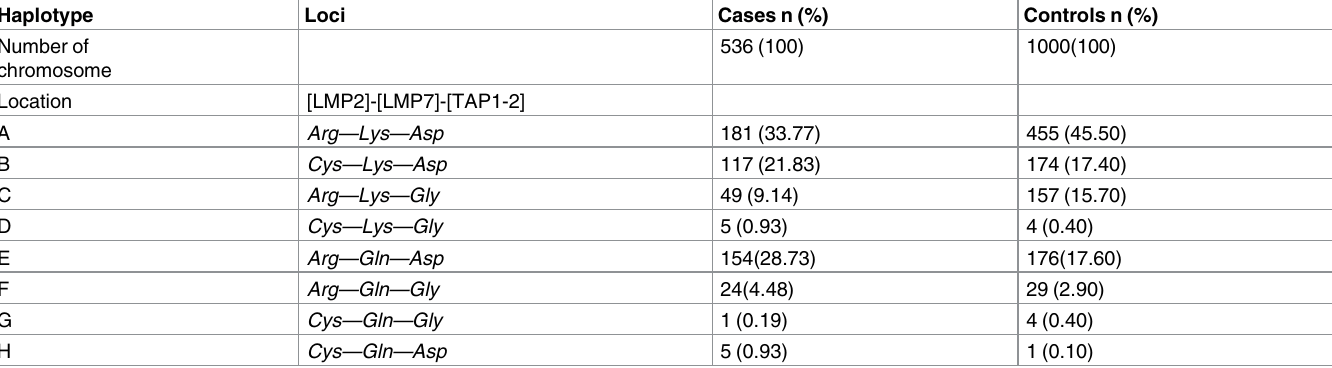
Table 5. Distribution of estimated haplotype frequencies for LMP/TAP genes in cases and controls.